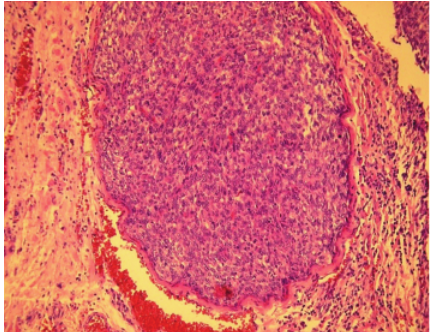
Figure 3: Hematoxylin-eosin staining, 200x, tumor